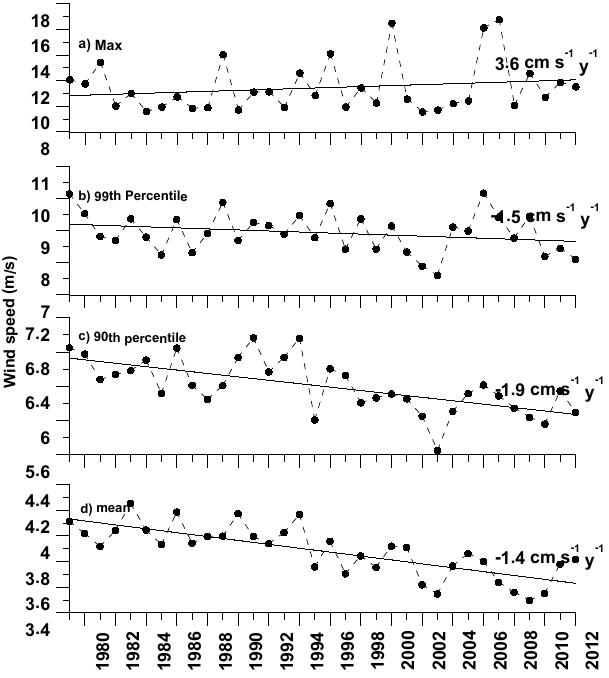
Figure 5. Long-term trend in annual (a) maximum, (b) 99th per- centile, (c) 90th percentile and (d) mean wind speed from 1979 to Figure 5. Long term trend in annual (a) maximum, (b) 99 th percentile, (c) 90 th percentile and (d) 462